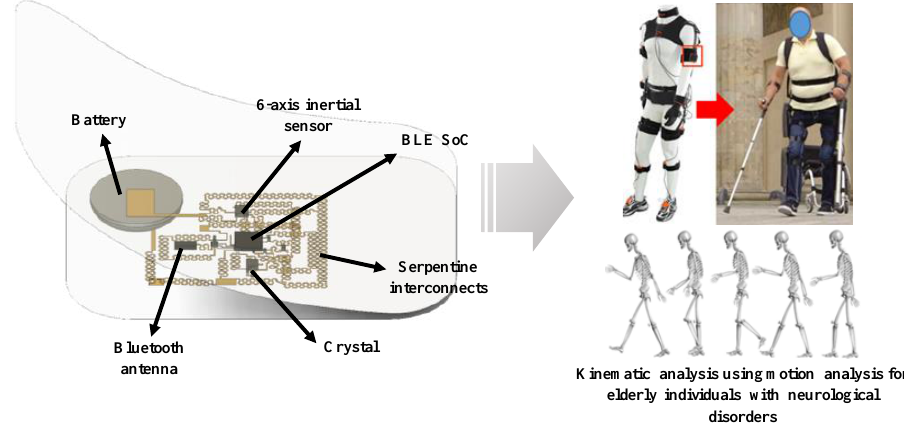
Figure 1. Schematic of a patch-type wireless inertial measurement unit (IMU) and its applications. BLE: Bluetooth Low Energy; SoC: system-on-a-chip.